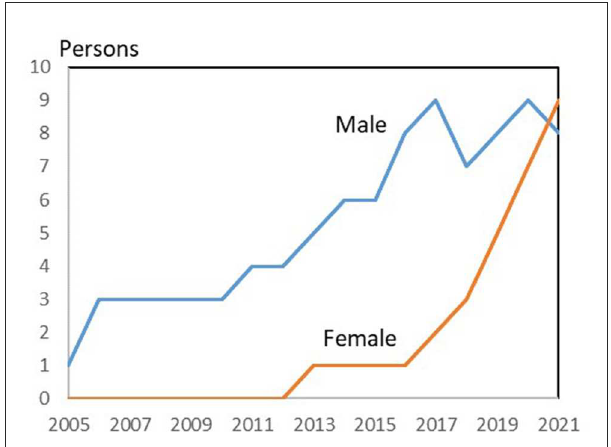
FIGURE8 Share of women on boards of farmer-owned cooperatives in different sectors (2021). “Other” includes primarily